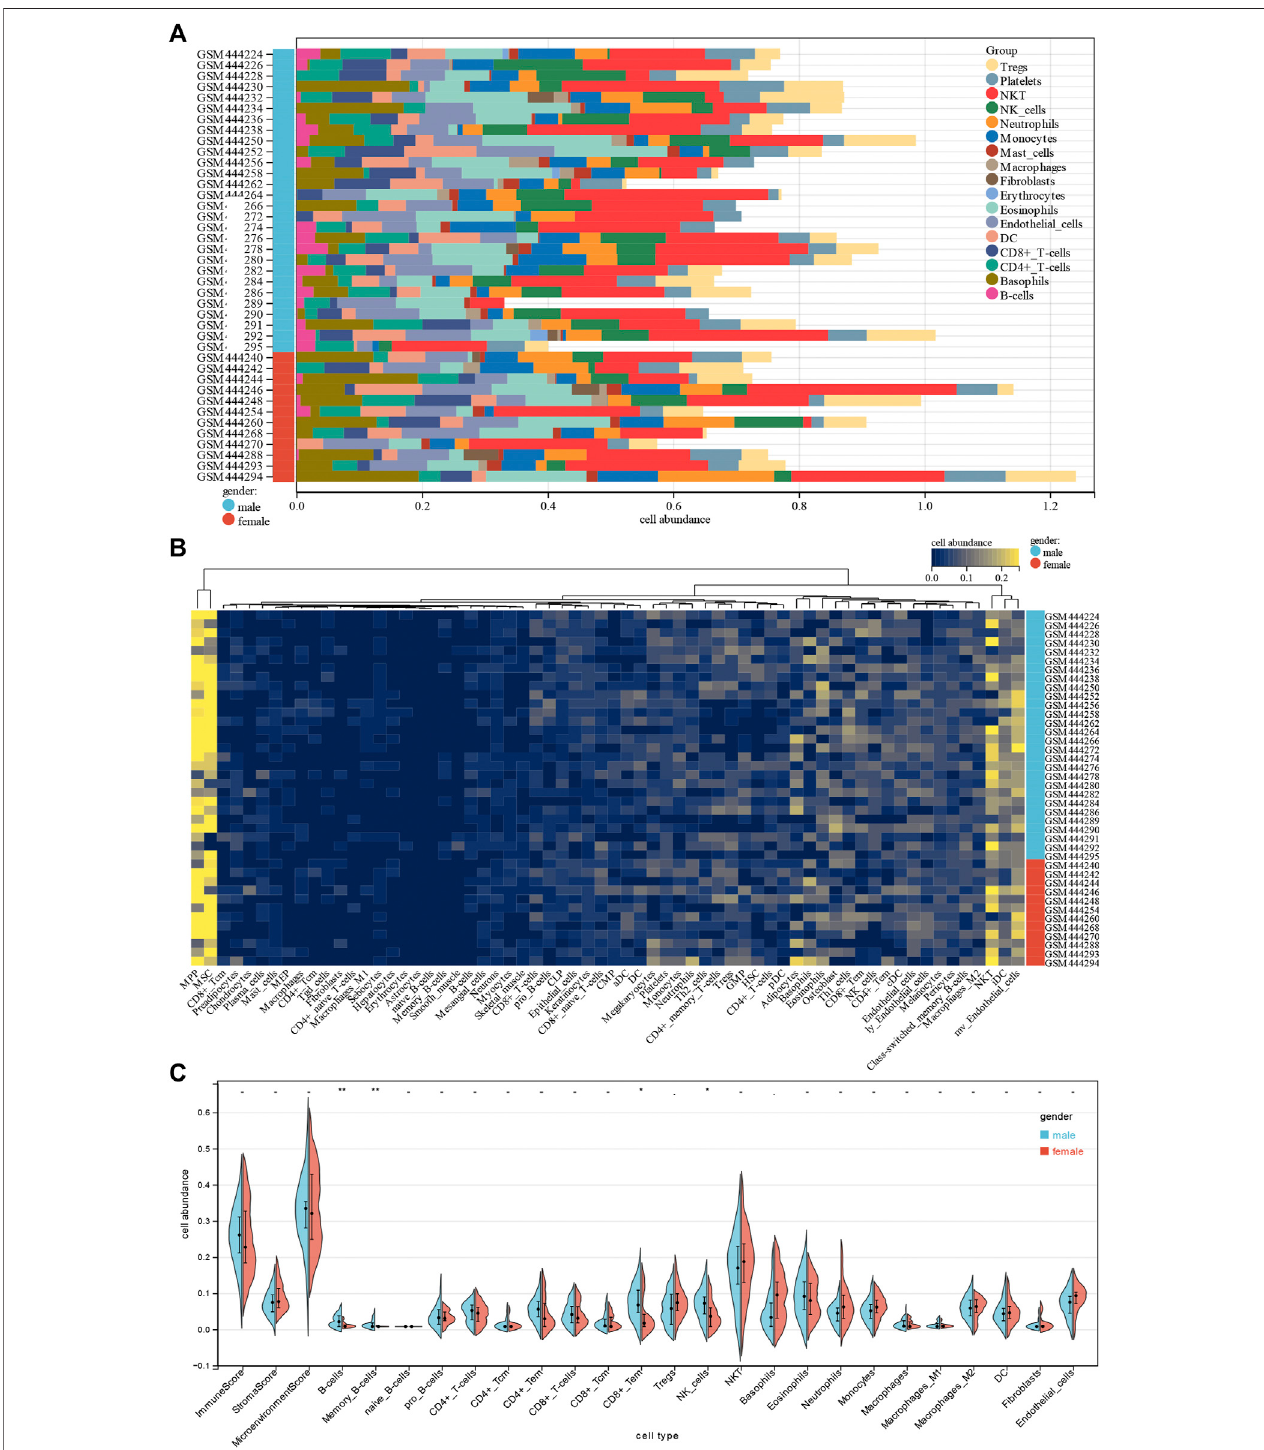
FIGURE 2 | Correlations of gender with immune in fi ltration level in DCM tissues. (A) Distribution of immune cell in fi ltration in each sample. (B) Heatmap of immune cell types. (C) Violin plot of in fi ltrating immune cells.